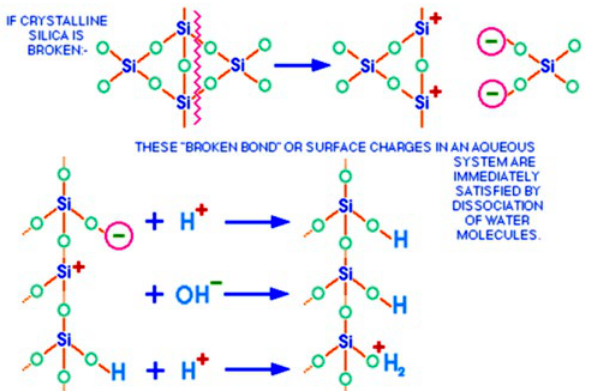
Figure 4. If crystalline silica is broken the “broken bonds” or expo- sed surface charges in an aqueous system are immediately satisfied by dissociation of water molecules. If the surface is large it will car- ry an ‘overall’ or residual charge which adsorbs polar water molecu- les as an adsorbed water monolayer.